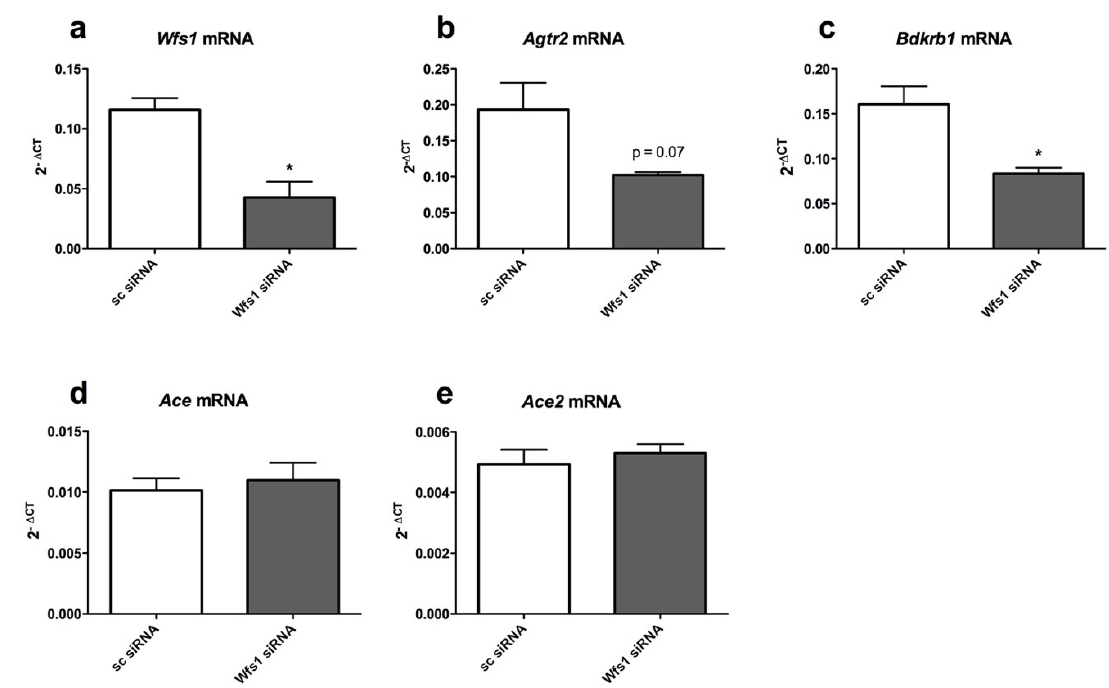
Figure 4. The expression of Agtr2 and Bdkrb1 is downregulated in in vitro Wfs1 knock–down. Rat primary cortical neurons were transfected with control or Wfs1 siRNA using the N-TER nanoparticle siRNA transfection system and gene expression analysis was performed to measure the relative expression level of ( a ) Wfs1 mRNA, ( b ) Agtr2 mRNA, ( c ) Bdkrb1 mRNA, ( d ) Ace mRNA and ( e ) Ace2 mRNA. Gene expression level is presented as 2 − ∆ CT relative to the housekeeper Hprt . Data were compared using unpaired t test; * p < 0.05 compared to scramble siRNA. The data are presented as the mean ± SEM, n = 3 per group.